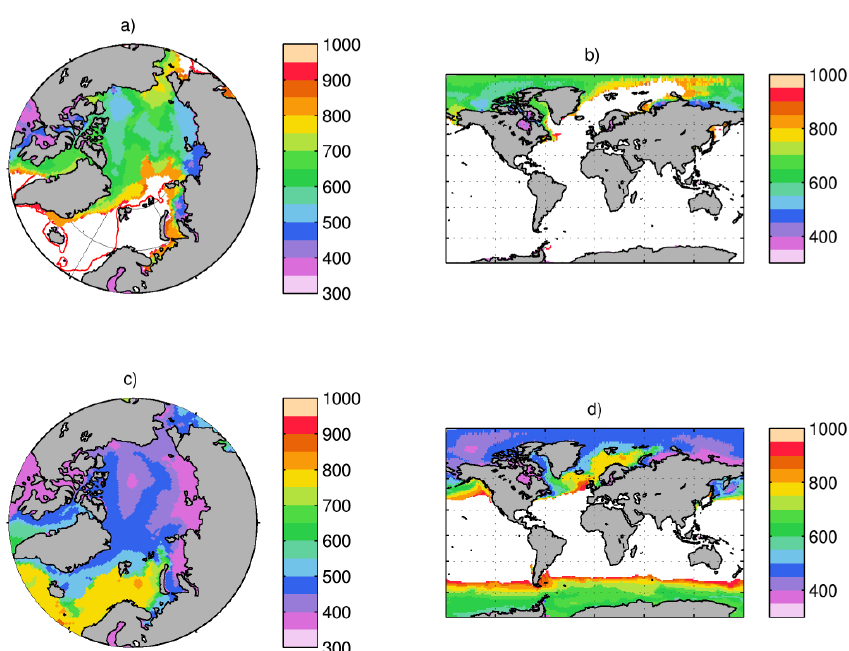
Fig. 11. Level of atmospheric CO 2 (ppm) under which monthly mean undersaturated surface waters occur for the fist time in respect to calcite (a, b) and aragonite (c, d)